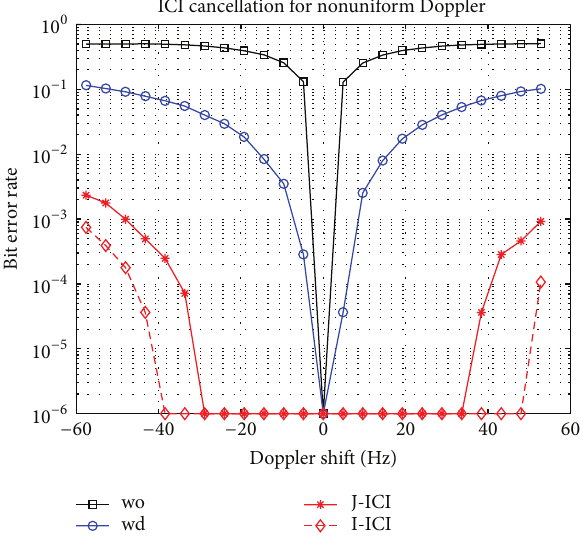
Figure 5: Performance of ICI cancellation for nonuniform Doppler.